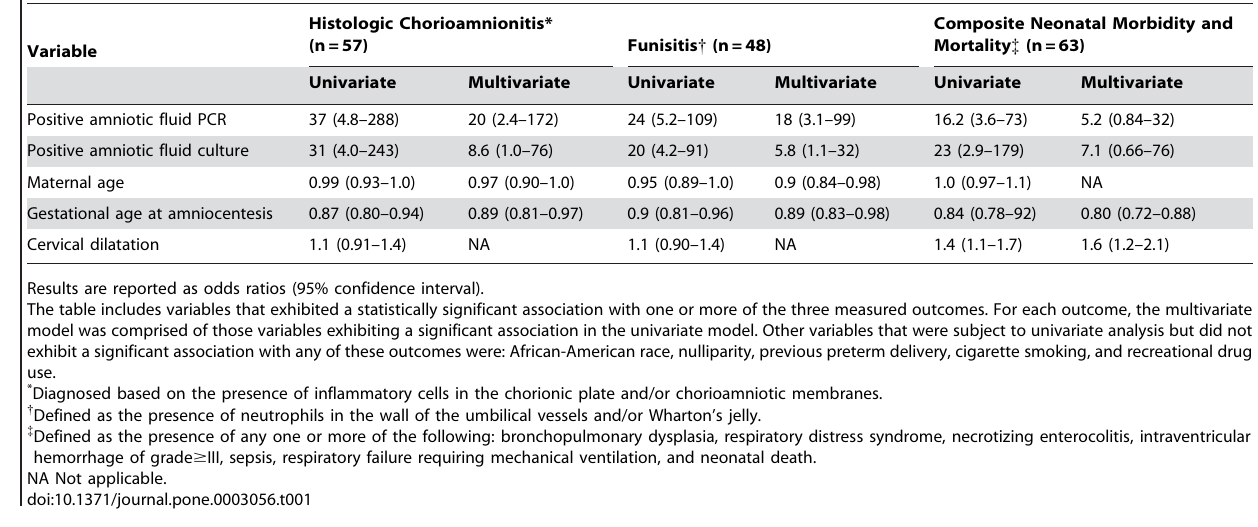
Table 1. Factors Associated with Histologic Chorioamnionitis, Funisitis, and Neonatal Morbidity and Mortality.